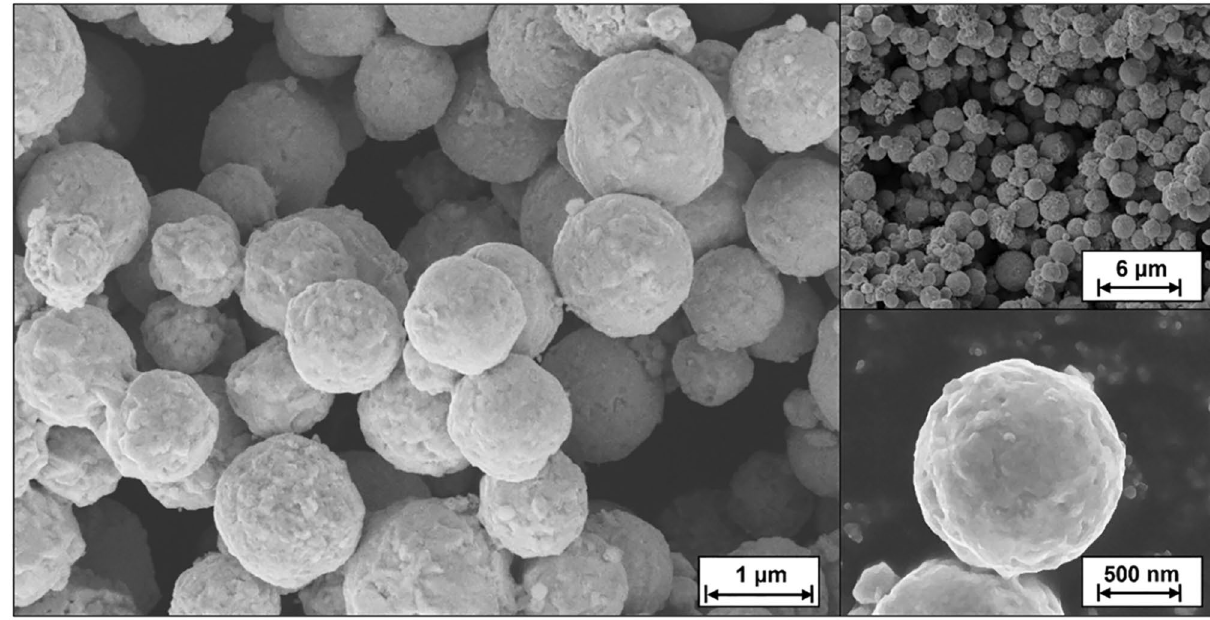
Figure 2. SEM images of Cu@Cu 6 Sn 5